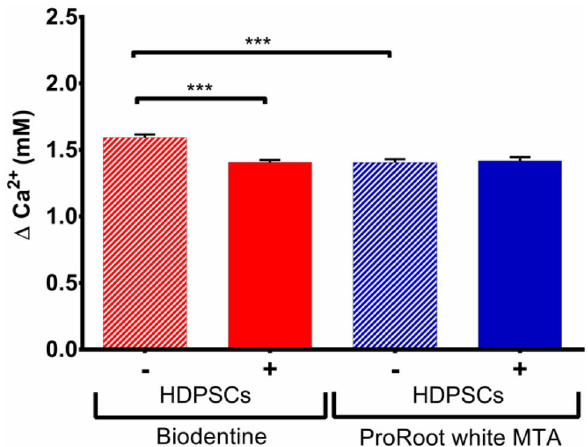
Figure 1. Changes in extracellular Ca 2+ ion concentration (mM) in α—MEM with and without hDPSCs after 30 min biomaterial exposure. One way ANOVA with Tukey post-hoc comparisons showed significantly higher Ca 2+ released by Biodentine than ProRoot WMTA ( p < 0.001) when no cells were present. In the presence of hDPSCs, the larger Biodentine-triggered extracellular Ca 2+ increase was significantly reduced to the level observed with ProRoot WMTA ( p <